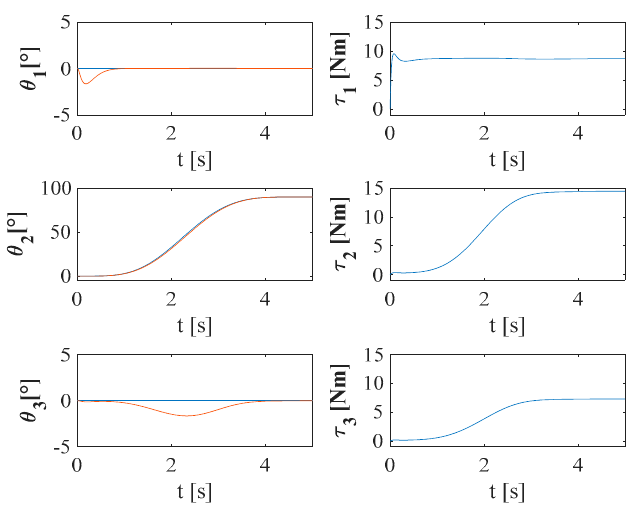
Figure 8. Response for a flexion movement with the PID controller considering the weight of the patient’s arm.